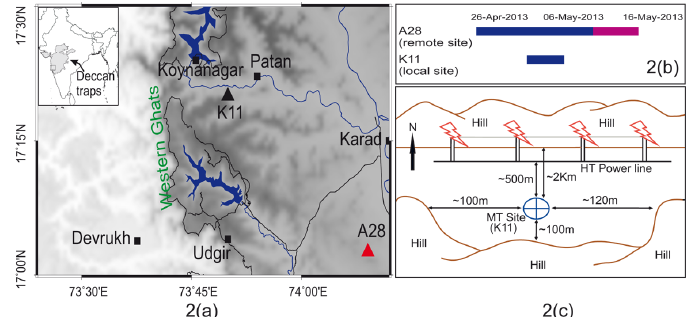
Figure 2. Local and remote sites and the surrounding topography. (a) Map showing the local site K11 (black triangle) and remote site A28 (red triangle). The remote site is in S-E direction at a distance of 50 km from the local site. The black colored squares represent the places in and around the Koyna-Warna region. (b) Data acquisition time plot between the local and the remote stations for the long period data (32 Hz sampling frequency). (c) A rough sketch of the site showing the topography and powerline distribution with approximate